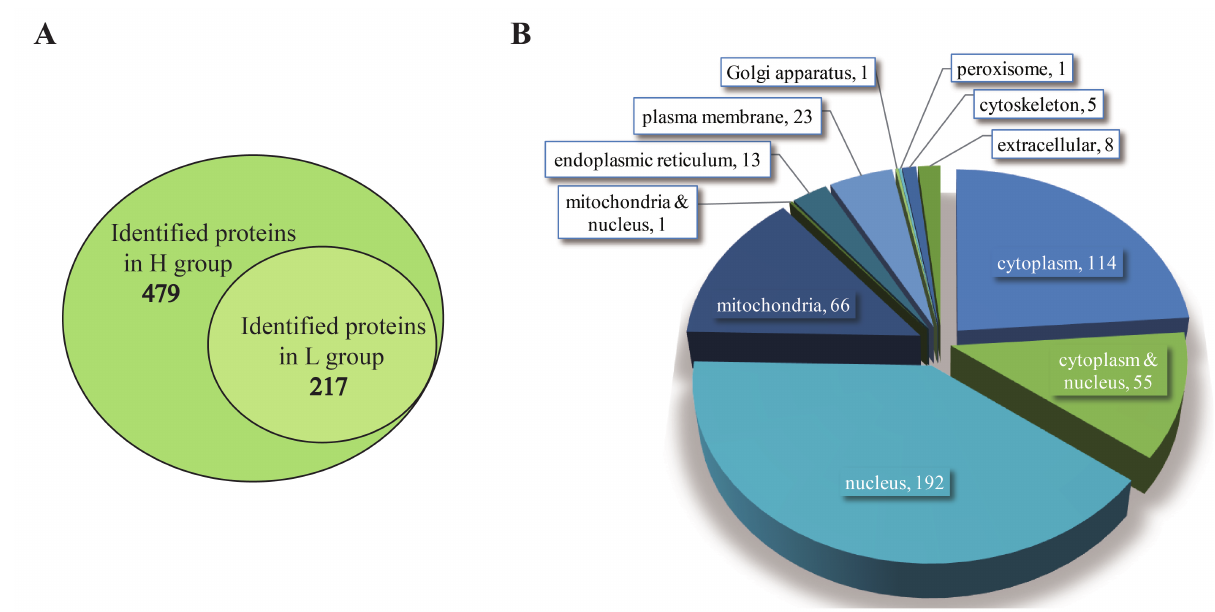
Figure 7. Information of identified pathogen proteins in the H and L group. ( A ): Statistic data of EHP proteins. The outer ellipse represents 479 EHP proteins found in the H group, and the inner ellipse indicates 217 EHP proteins were found in the L group. ( B ): Predicted subcellular location of EHP proteins found in infected groups. Protein numbers were shown on or side of each